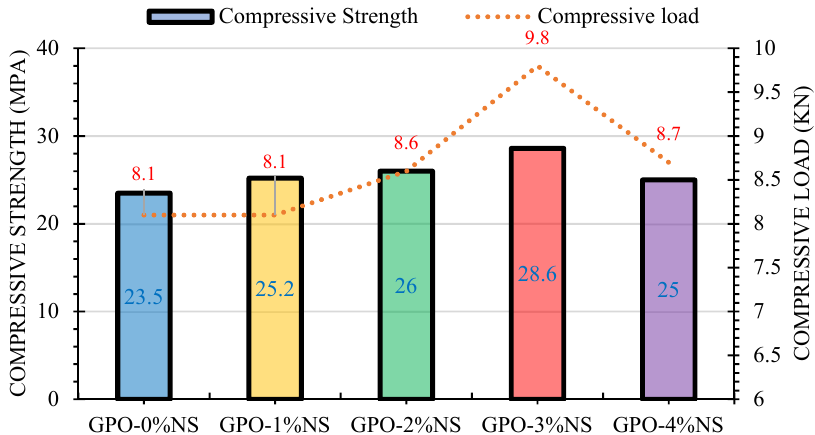
Figure 3. Effect of different quantities of NS on the COS and compressive loads of mixes. The COS with carbon fibers in most GPO composite pastes with different percentages of NS (0%, 1%, 2%, 3%, and 4%) was greater than that of pastes without carbon fibers [21]. This proves the viability of adding 0.5% of carbon fiber to a GPO mix with different concentrations of NS. Following the incorporation of carbon fibers, an improvement was seen due to the more densified microstructure and equivalent higher load-conveying limit of the mix, as displayed in Figure 3. Along these lines, it was clear that the addition of 0.5% carbon fiber and 4% NS improved the COS of the blends. The correlation of the relative COS GPO composite mixes and without NS and various concentrations of NS (such as the control blend (GPO-0%NS)) is displayed in Figure 4. The COS of GPO composite blends with NS concentrations of 1%, 2%, 3%, and 4% and a carbon fiber concentration of 0.5% was increased by 107.2%, 110.6%, 121.7%, and 106.4%, respectively, in comparison to the COS of the control blend with 0.5% of carbon fiber and no NS.